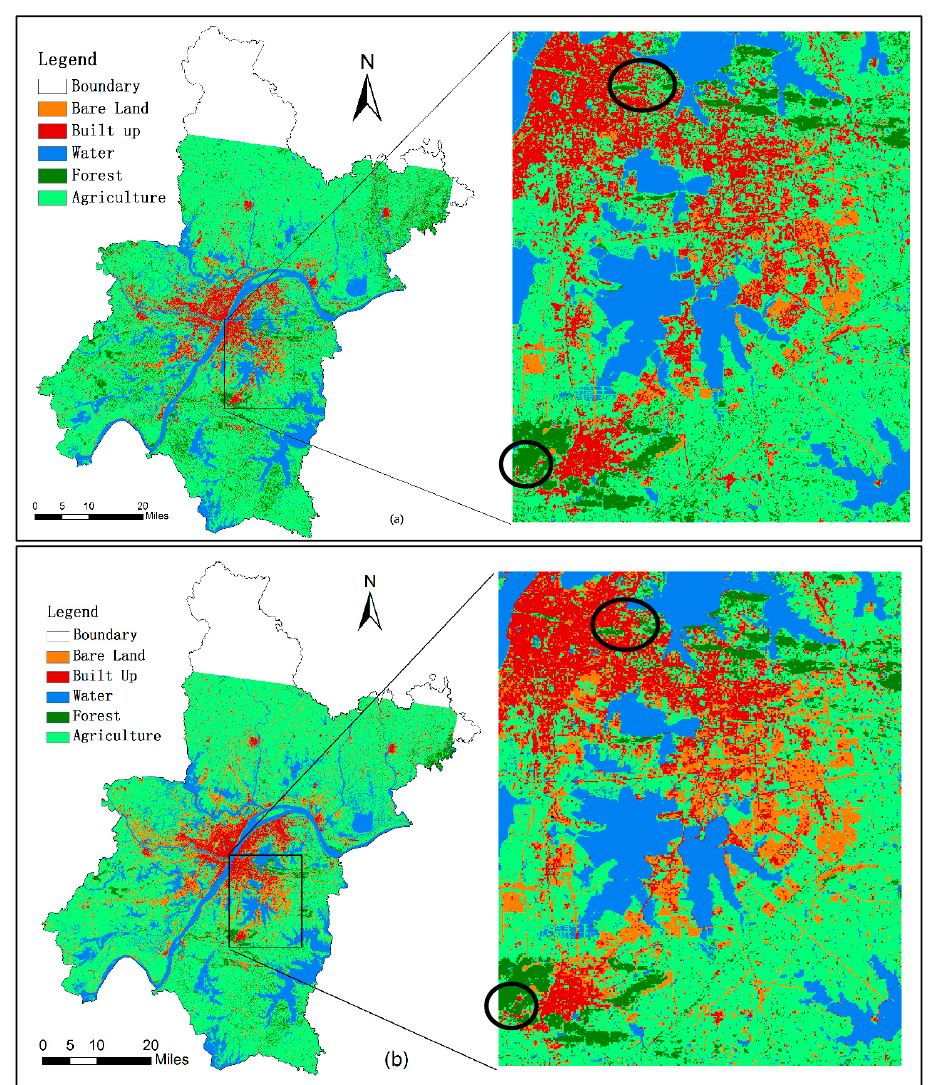
Figure 6. Supervised classification: ( a ) ASC results and ( b ) TSC results.